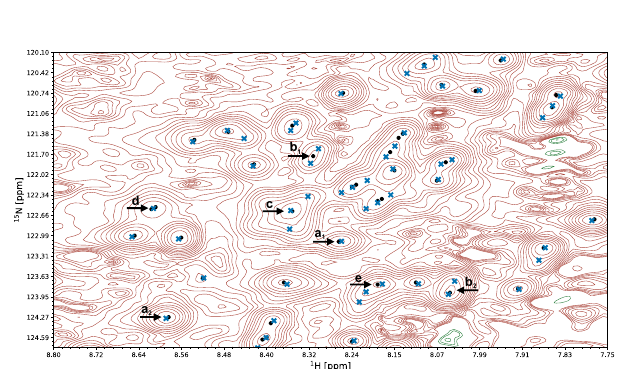
Fig.6|Commonlyoccurringchallengesinvisualspectrumanalysis. Afragment of a 15 N-HSQC spectrum of the protein 1T0Y is shown. Initial signal positions identi fi ed by the peak picking model pp-ResNet (black dots) are deconvolved by deconv-ResNet, yielding the fi nal coordinates used for automated assignment and structuredetermination(bluecrosses). a 1 , a 2 Initialpeakpickingmarkerpositionis re fi ned by the deconvolution model. b 1 , b 2 pp-ResNet output is deconvolved into two components. c The deconvolution model supports maximally 3 components per initial signal. d Two peak picking markers are merged by the deconvolution model. e Peak picking output deconvolved into three components.